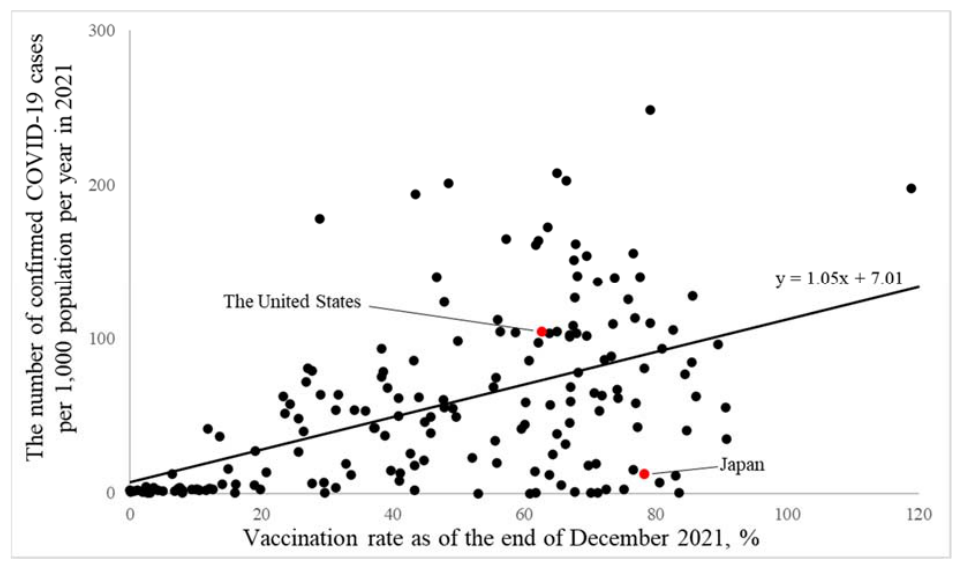
Figure 1. An international association of vaccination rate with the number of confirmed COVID ‐ 19 cases per year in 2021 in the world. The line shows the slope based on the generalized regression model as an approximated curve. The covariate was not included in this model.